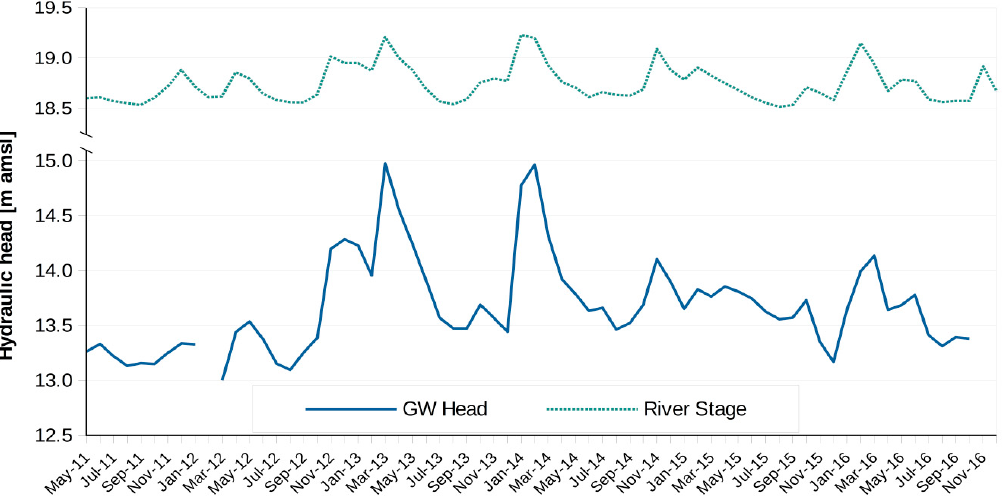
Figure 6. Monthly groundwater head data at the Serchio River RBF plant and Serchio river stage at the Ponte di Monte San Quirico monitoring station from May 2011 to December 2016 (data courtesy of Servizio Idrologico Regionale—Regione Toscana). The locations of the piezometer and the Serchio river monitoring station are marked in Figure 4.